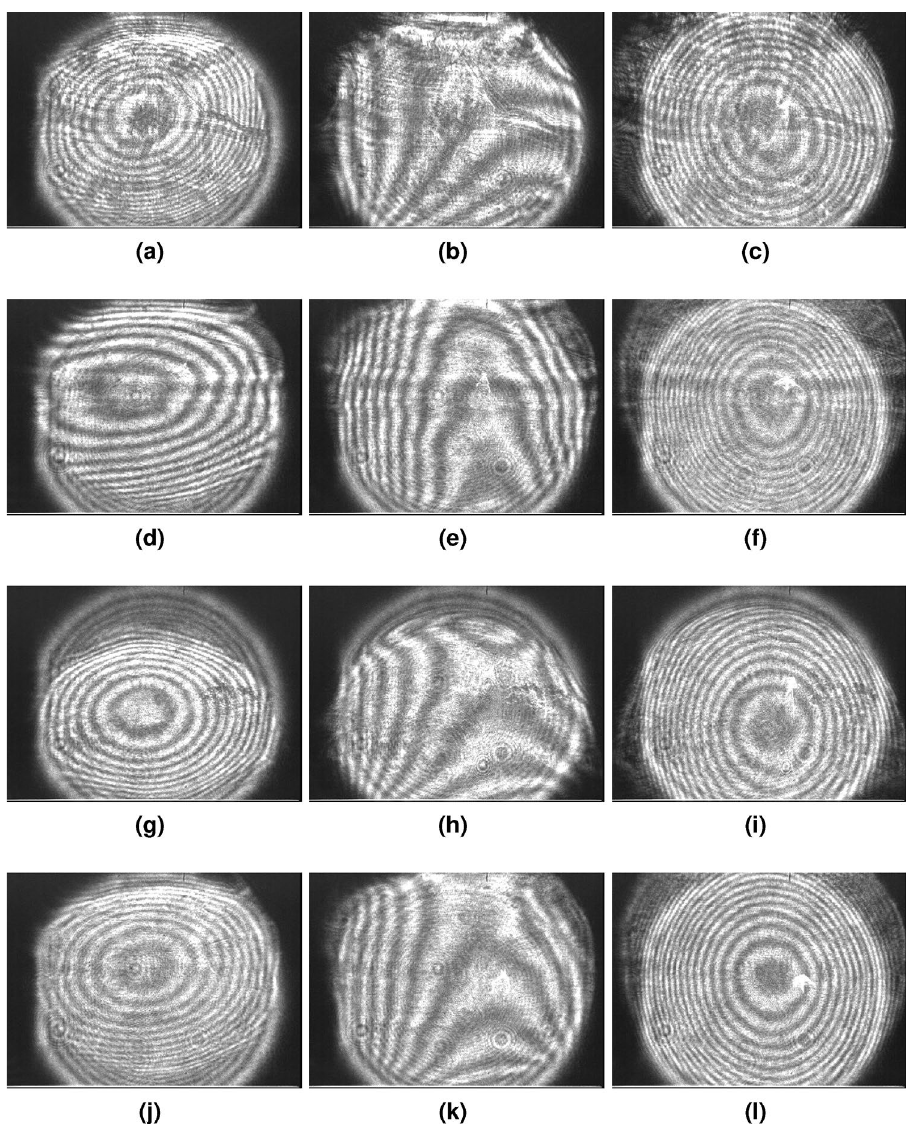
of f = f RB − 1cm , f = f RB , and f = f RB + 1cm i.e., central images ( b ), ( e ), ( h ), and ( k ) are balanced state interferograms for samples A, B, C, and D